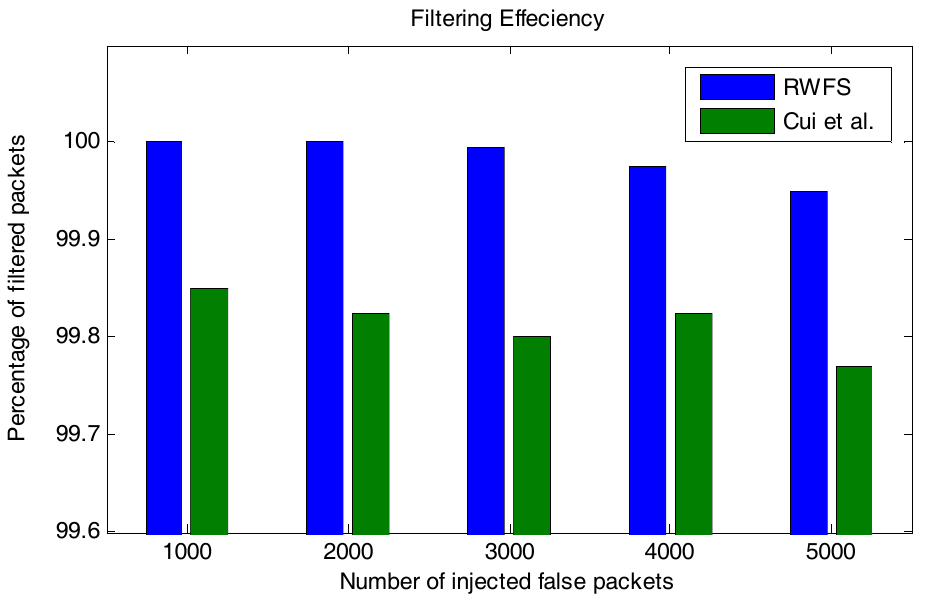
Figure 6. The filtering efficiency analysis between RWFS (the proposed scheme) and the Cui et al. scheme. The bar graphs show the percentage of filtered malicious packets for a different scenario where a different number of false packets was injected.